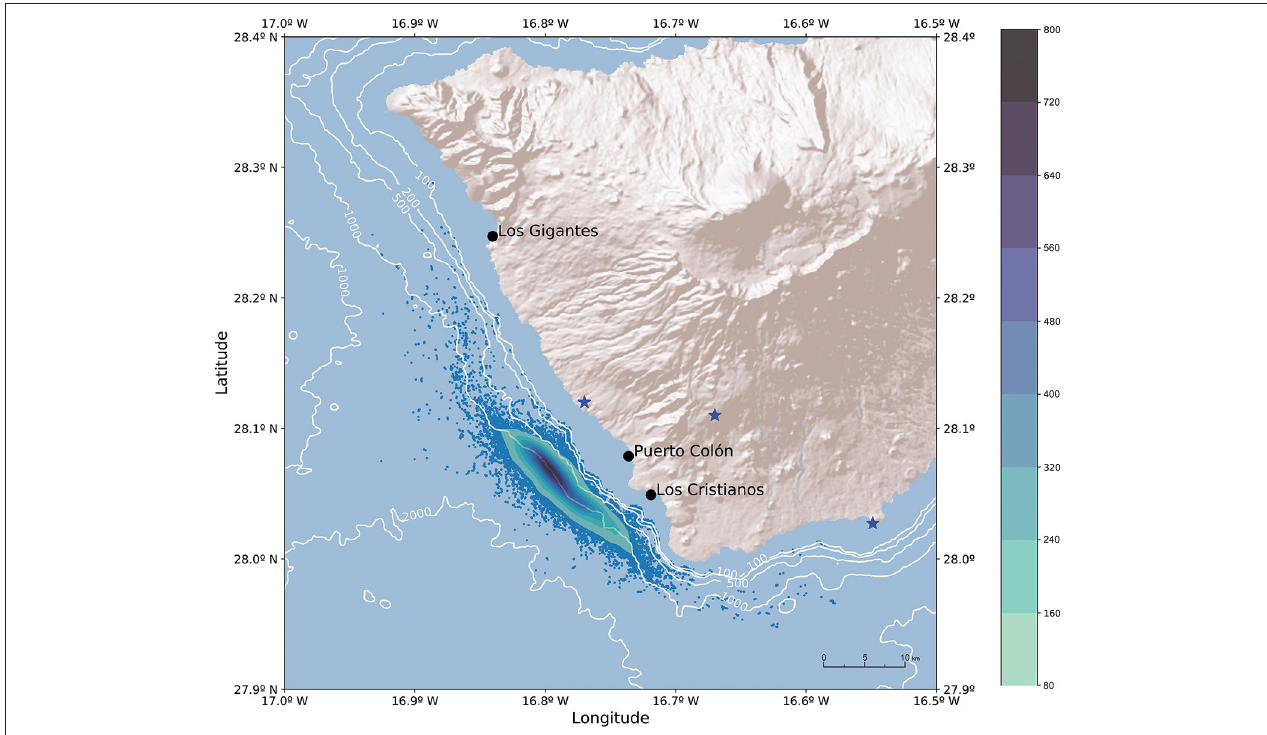
FIGURE 4 | AIS messages broadcasted from potential whale watching events (blue dots) and density map of the potential whale watching events off Tenerife Island. Location of the main harbors (black dots) and the AIS terrestrial stations (blue stars) in the region.White lines represent isobaths in